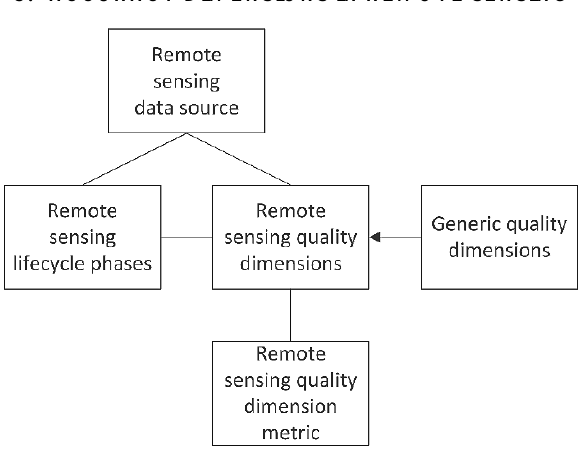
Figure 1. Remote sensing data quality context (compiled